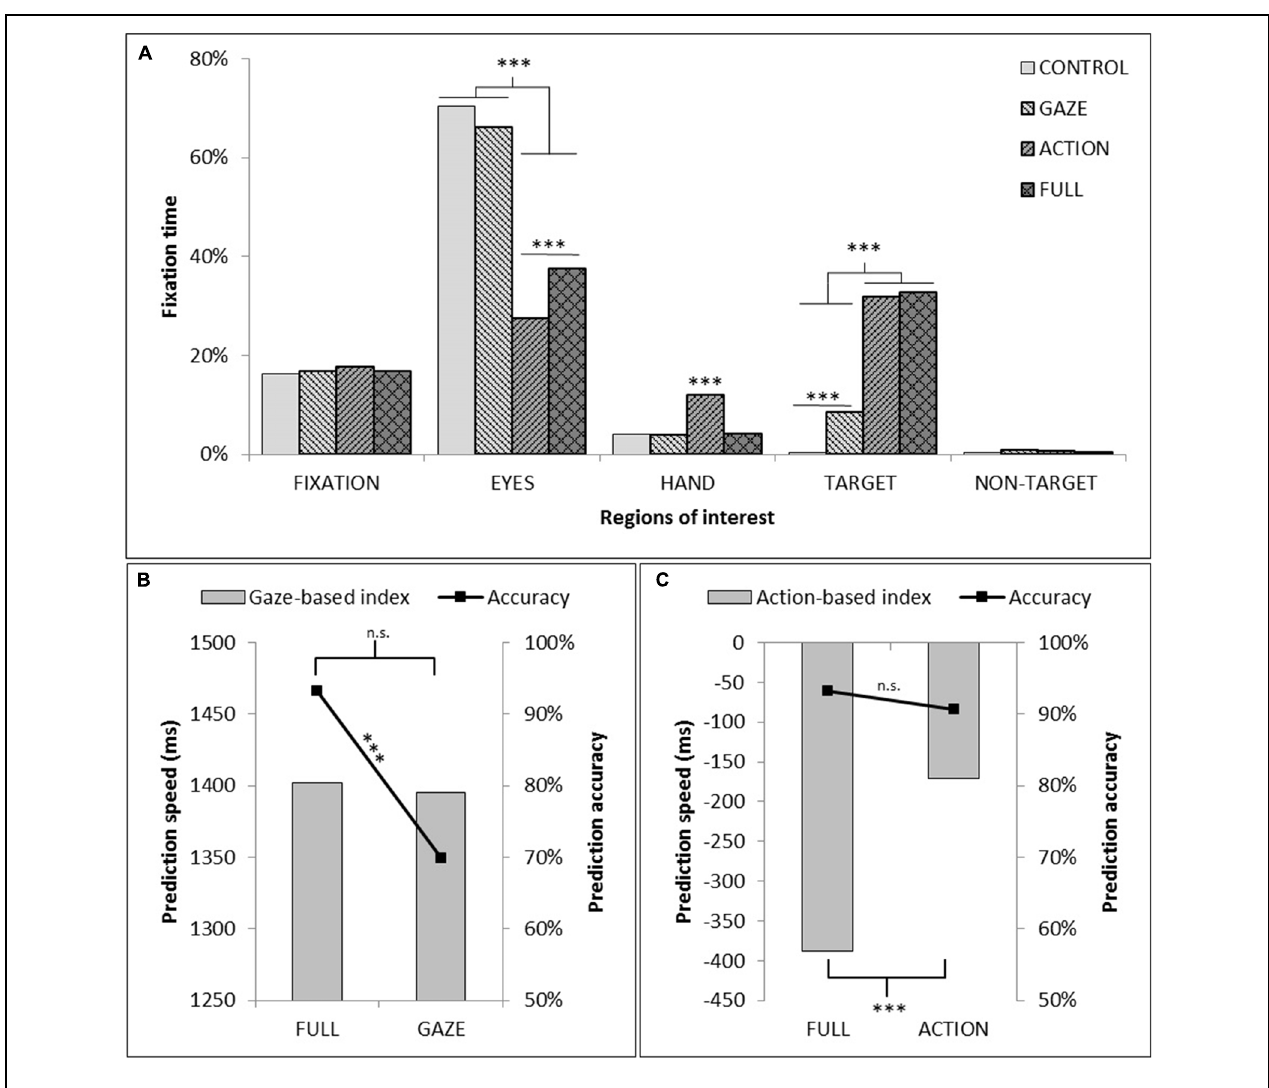
FIGURE 3 | (A) Proportion of total fixation time within each of the five ROIs as a function of observation conditions (In the CONTROL condition, as no specific object could be reported as ‘TARGET’ or ‘NON-TARGET,’ the average fixation time on both objects was plotted). (B) Measure of the contribution of action information to prediction speed and prediction accuracy through the